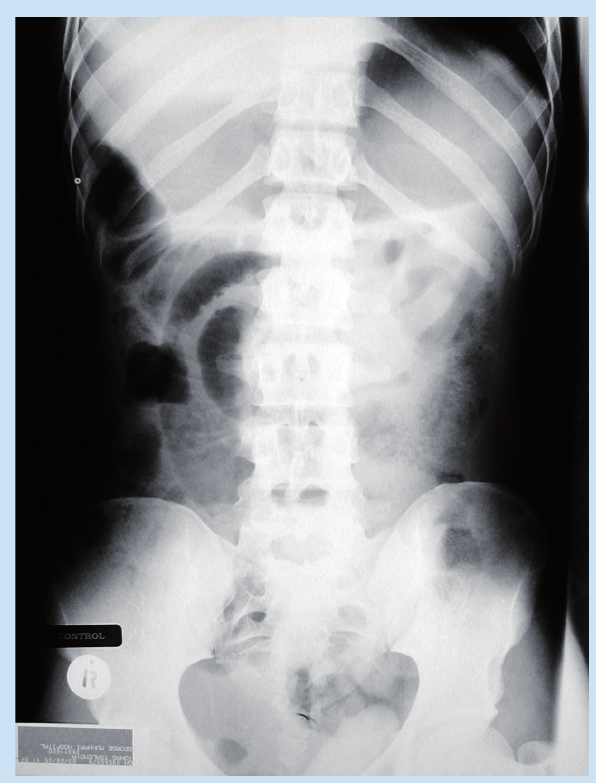
Fig. 1. Control film done for barium meal shows the encapsulated cluster of small bowel loops in the right midabdomen.